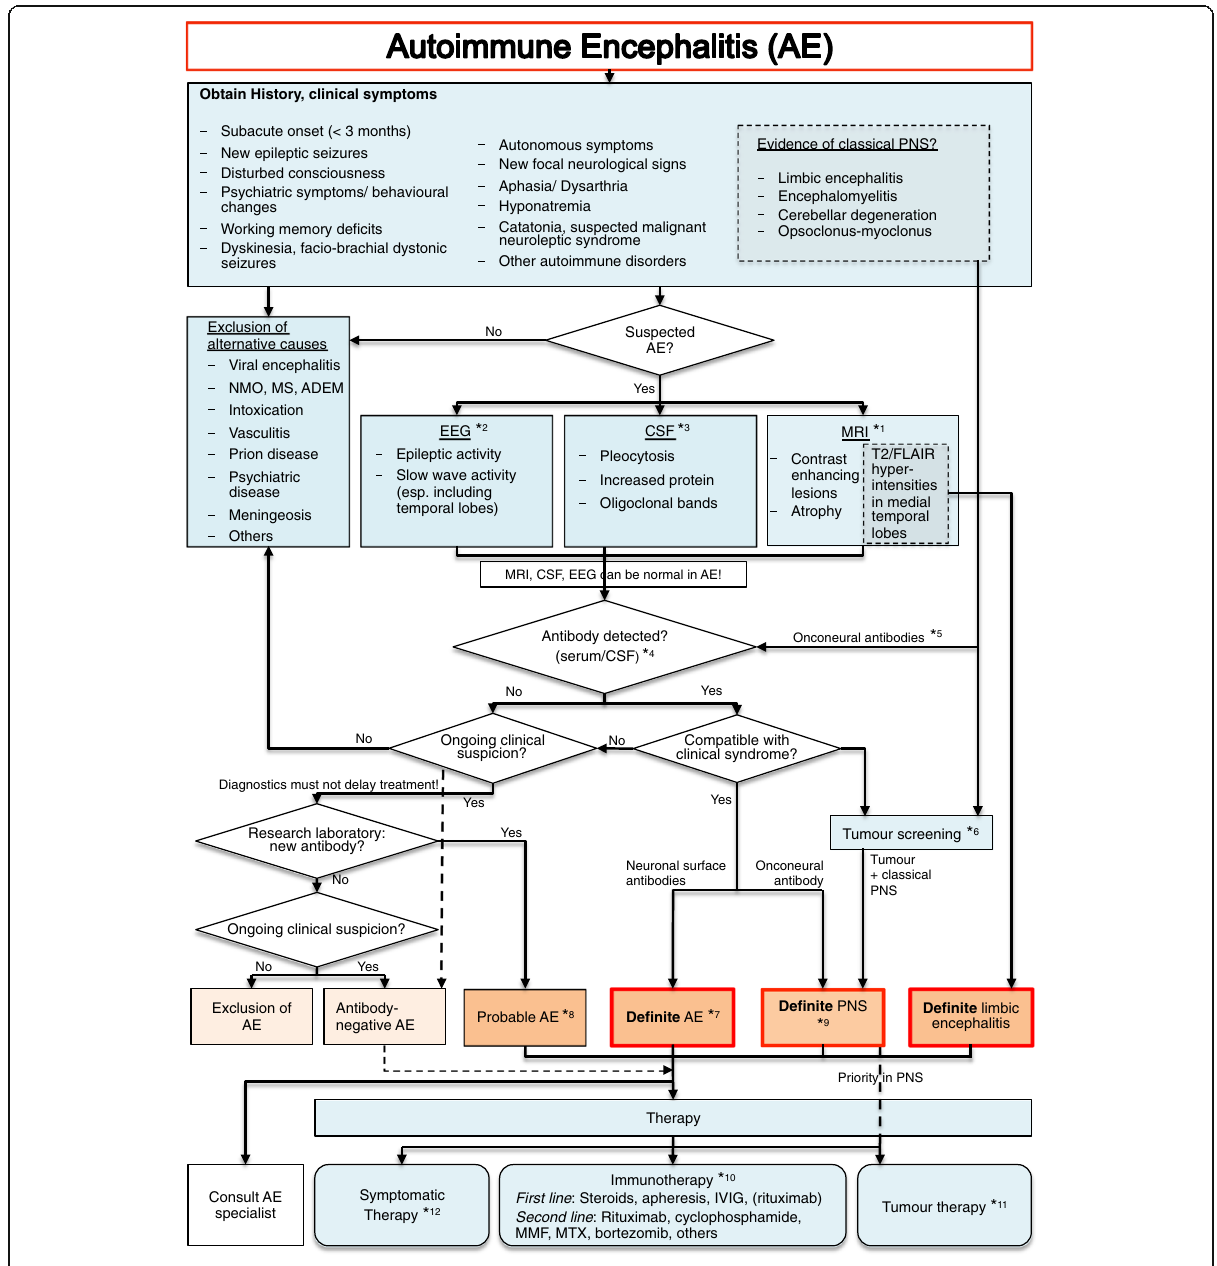
Fig. 1 Flow chart for the diagnosis of suspected autoimmune encephalitis. AE: Autoimmune encephalitis, PNS: paraneoplastic neurological syndrome, CSF: cerebrospinal fluid, FLAIR: fluid attenuated inversion recovery, MTX: methotrexate, MMF: mycophenolat mofetil, IVIG: intravenous immunoglobulin, NMO: neuromyelitis optica, MS: multiple sclerosis, ADEM: acute disseminated